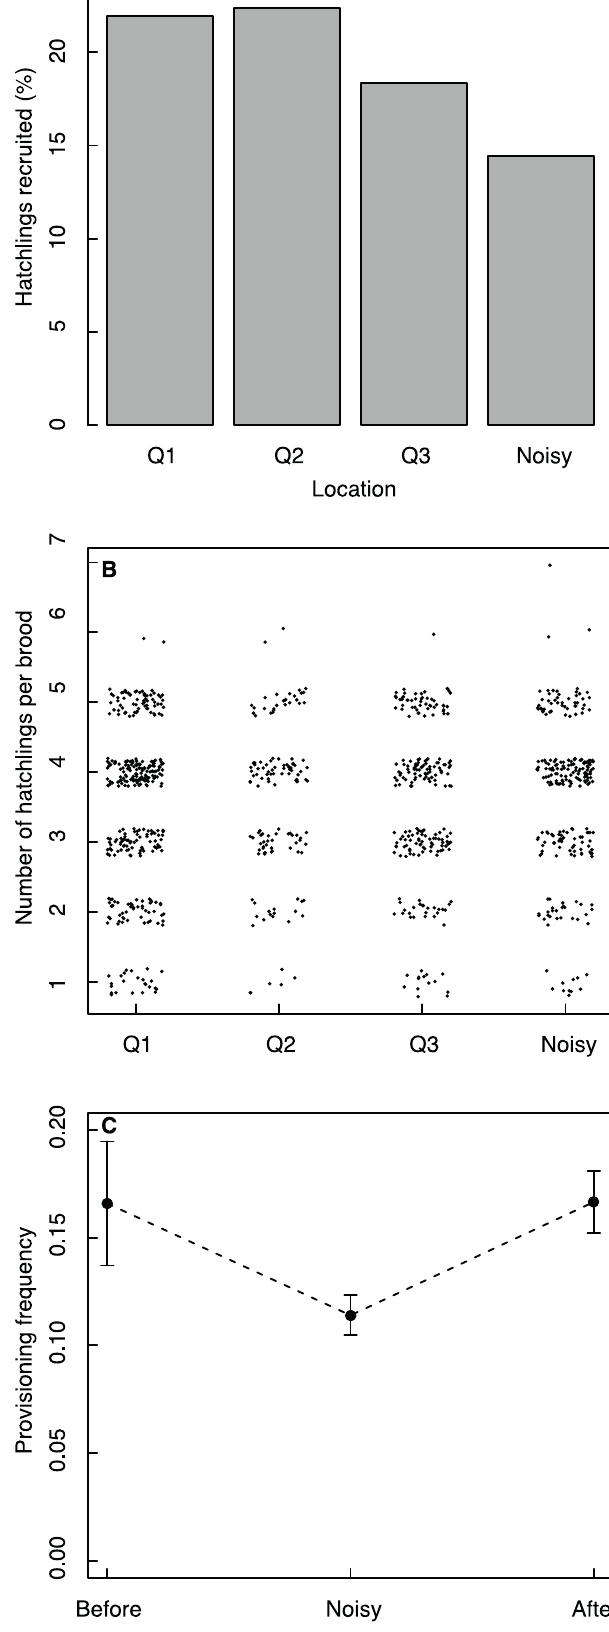
Figure 3. Reproductive success and provisioning frequency of Lundy island house sparrows breeding in nestboxes in the noisy area and elsewhere. (a) Percentage of house sparrow hatchlings that recruited to the breeding population, in relation to the environment in which they were raised (Q1–3= quiet, N = noisy). These data are not corrected for natal brood and foster area. (b) Number of Lundy house sparrow hatchlings per brood in relation to brood area (jittered). (c) Provisioning frequency (visits per minute) within individual female house sparrows that bred in quiet environ- ments before and after they bred, or both, in the noisy environment. N =69 females switched between noisy and non-noisy locations between broods. Whiskers depict one standard